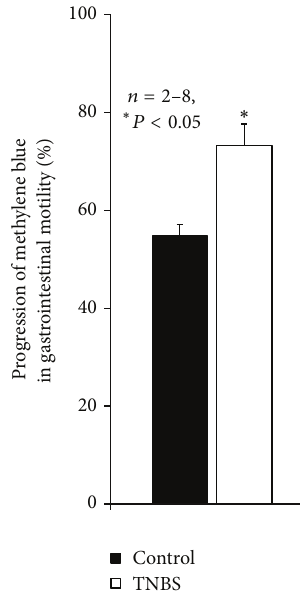
Figure 1: Progression of methylene blue dye gavage along the gas- trointestinal tract during 30 minutes in control and TNBS-injected animals.Thetotallengthofthesmallintestinewasusedtonormalize data. The vertical bars represent SEM. ∗ 𝑃 < 0.05 (unpaired Student’s t -test) represents significant differences as compared to the control